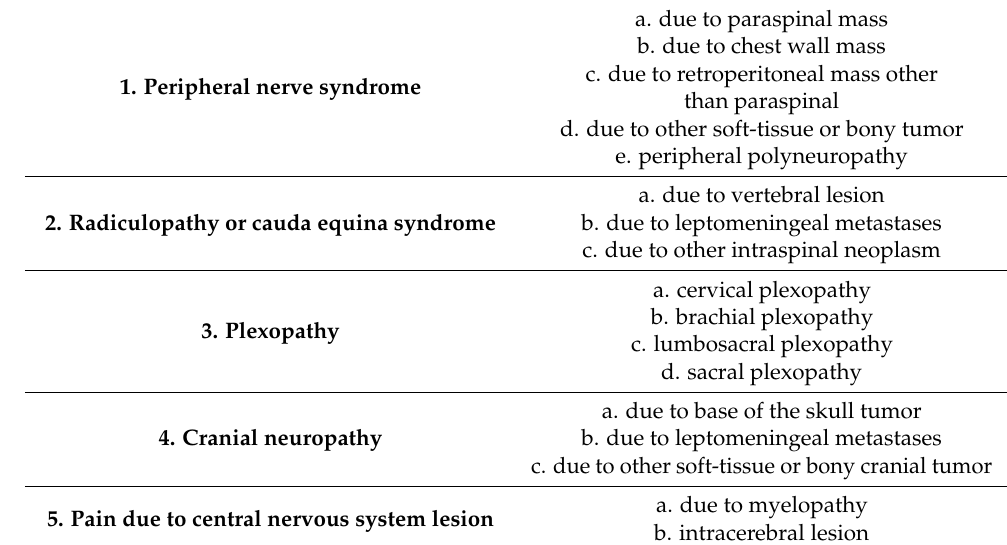
Table 1. Pain syndromes due to nervous tissue